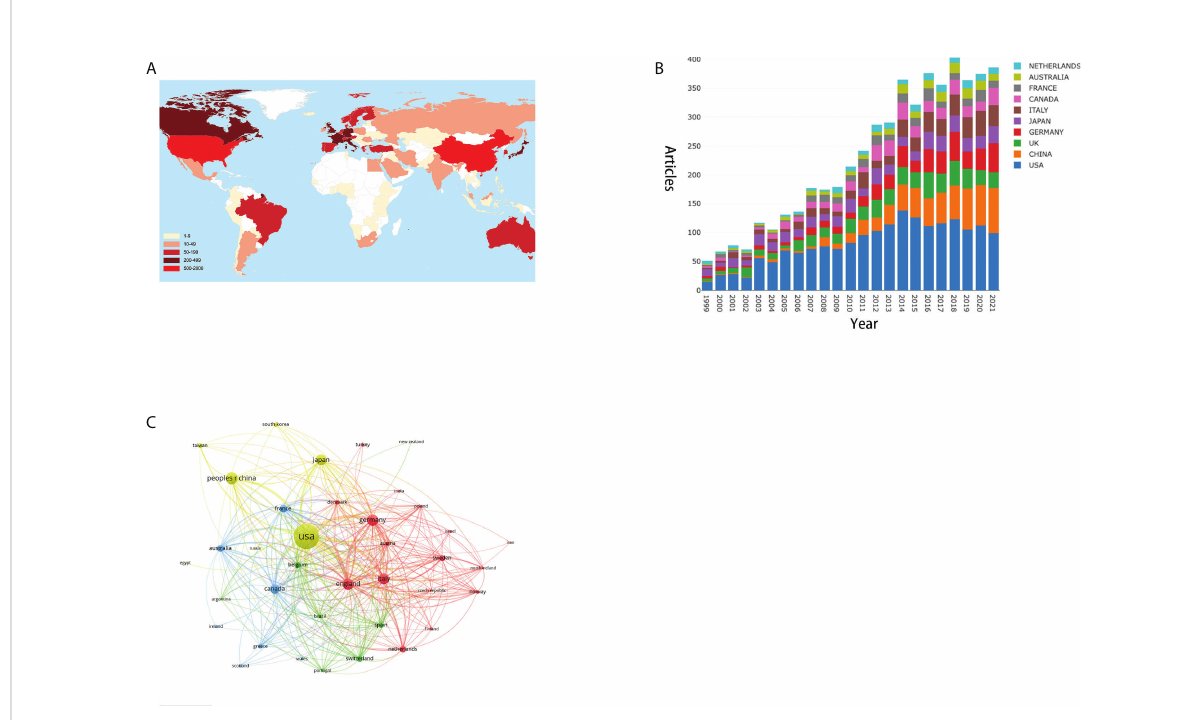
FIGURE 3 (A) Total articles per country/region. A different color indicates a different output. (B) Bar graph of the top 10 productive countries/regions. (C) Correlations among the countries/regions with more than 15 articles. The graph was generated by VOSviewer. Line thickness indicates the citation